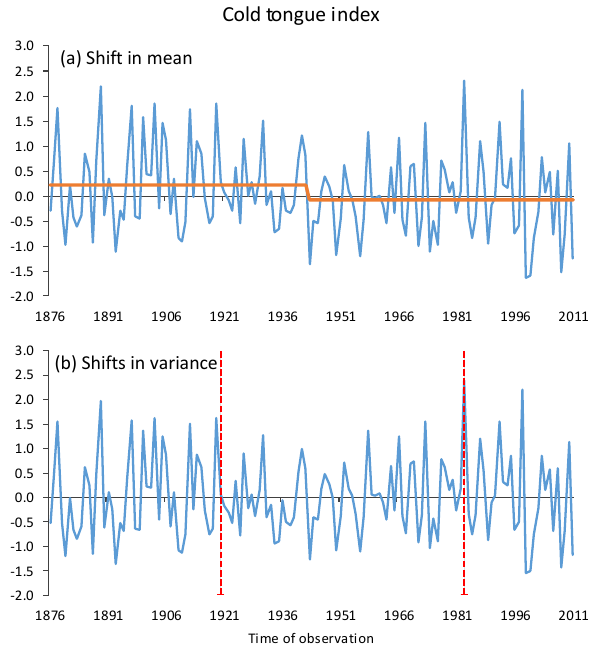
Figure 12. (a) Mean winter (DJF) cold tongue index, 1876–2011, showing a step shift downward in 1943 as detected by SRSD (0.1, 35, 3); (b) Residuals after removing the stepwise trend in the mean and regime shifts in the variance detected by SRSD (0.05, 35, 3) with change points in 1920 and